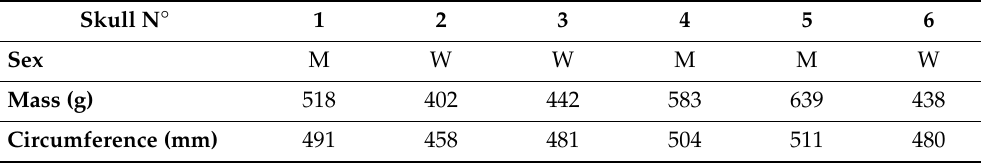
Table 1. Characteristics of the